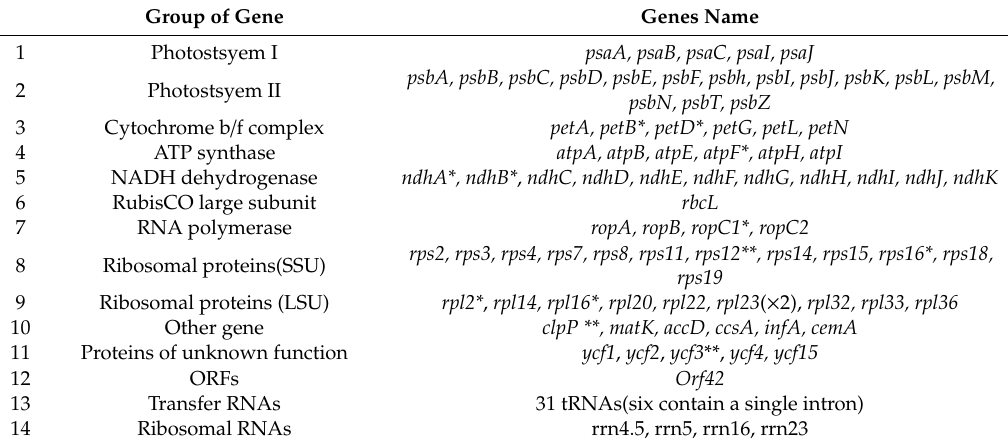
Table 2. Genes presented in the Acer sect. Platanoidea chloroplast genome.